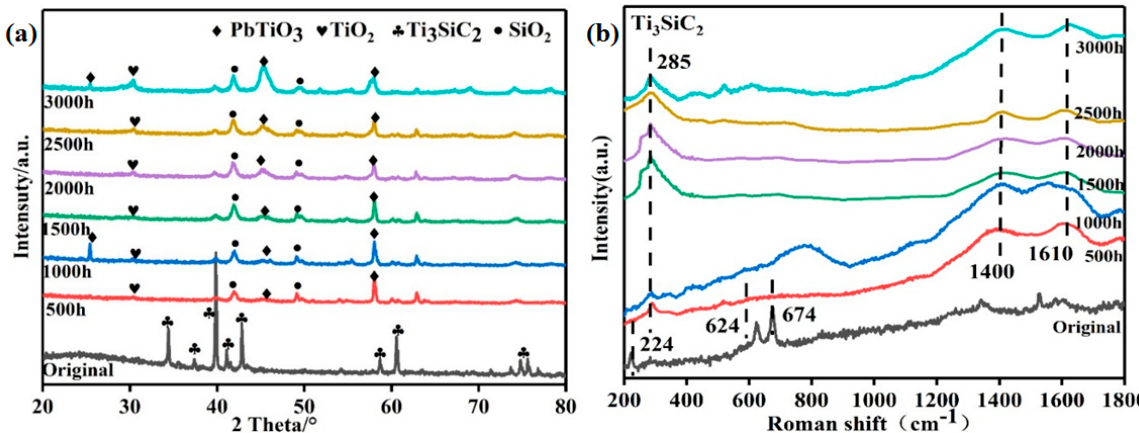
Figure 2. ( a ) XRD and ( b ) Raman results of Ti 3 SiC 2 samples before and after LBE corrosion.